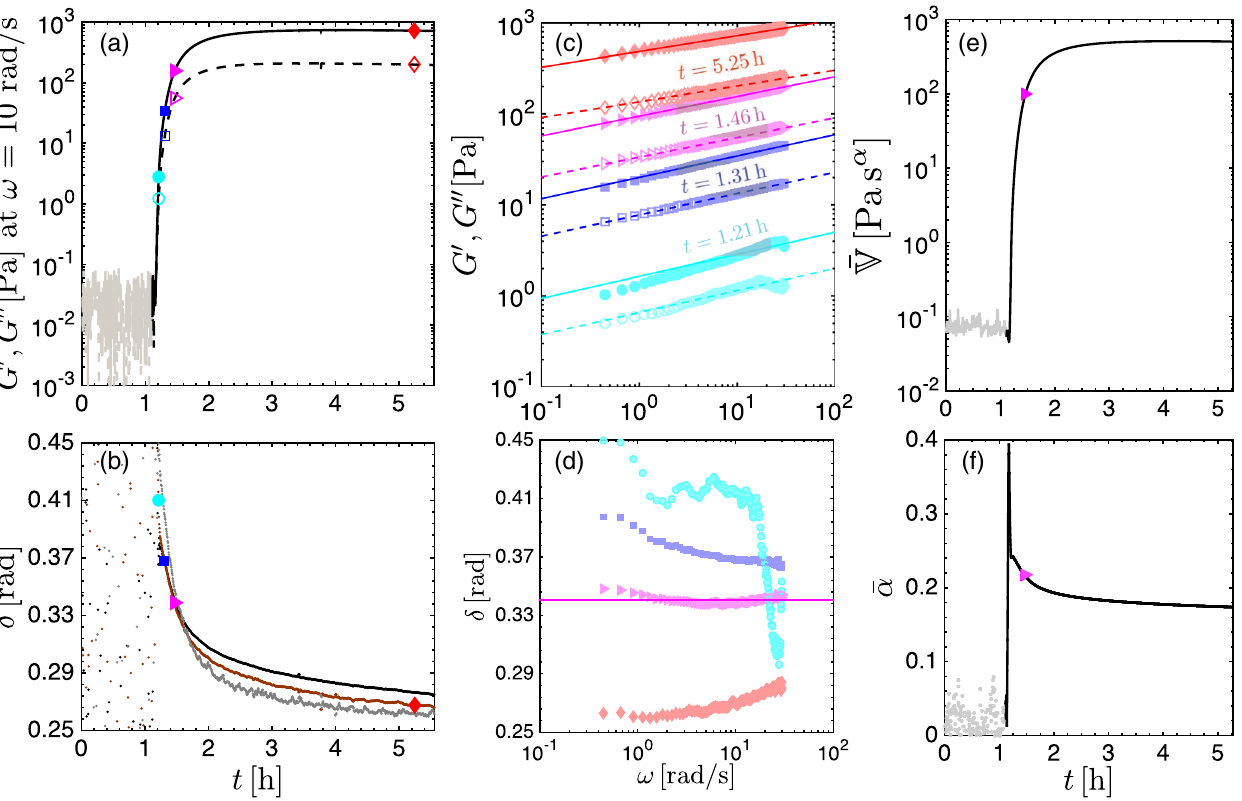
FIG. 4. Time- and frequency-resolved gelation of a casein gel obtained using an OWCh sequence with r ¼ 10% , T ¼ 14 s, ω 0 . 3 rad = s, ω 30 rad = s, TB ¼ 66 , t 1 s, and γ 1% . (a) Evolution of the viscoelastic moduli ( G 0 , line; G 00 , dashed line) 1 ¼ 2 ¼ 0 ¼ w ¼ as a function of the gelation time for one selected test frequency ( ω ¼ 10 rad = s). (b) Phase angle δ as a function of the time for different frequencies: ω ¼ 0 . 3 rad = s (grey line), ω ¼ 10 rad = s (brown line), and ω ¼ 20 rad = s (black line). At the gel point (indicated by the pink right pointing triangle), all three frequencies pass through a single value of δ , because the phase angle is independent of frequency [65,66,74]. (c) Viscoelastic moduli ( G 0 , closed symbols; G 00 , open symbols) and (d) phase angle as a function of frequency at different times 1 . 46 h (pink right pointing triangle), and during gelation: t ¼ 1 . 21 h (blue filled circle), t ¼ 1 . 31 h (violet filled square), t ¼ t g ¼ t ¼ 5 . 25 h (red filled diamond). Symbols and colors correspond to the points indicated in (a) and (b). At the gel point, the phase angle is invariant with the frequency (pink right pointingtriangle), while before and after there isa more pronounceddependence of δ on ω . The solid lines in (c) and (d) correspond to the model prediction obtained by assuming a mechanical model composed of a single fractional element as described in Sec. IV (the same color code applies). (e) and (f) show, respectively, the evolution in the gel strength and average relaxation exponent as a function of time. The respective values at the gel point are indicated with the same symbol (pink right pointing